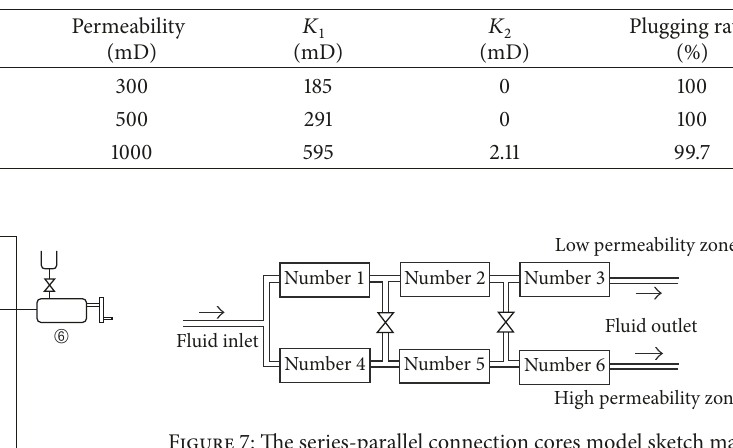
Table 4: The plugging rates of the ABP system in different permeability cores.